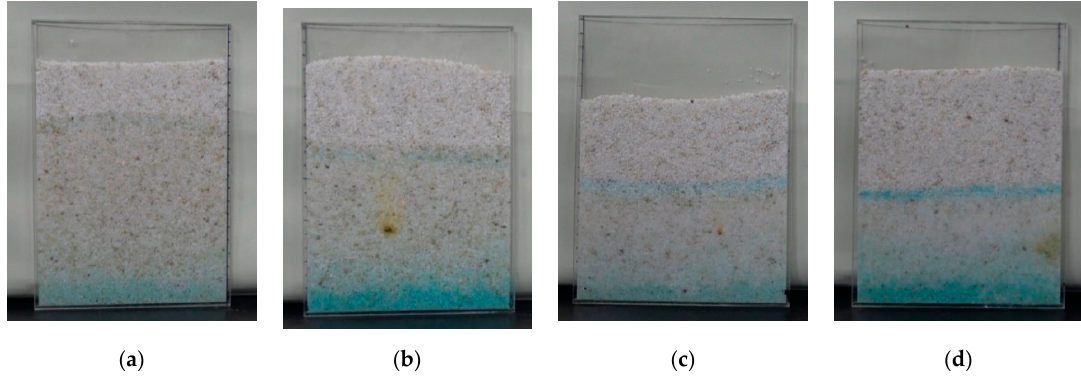
Figure 11. Surface state of the sample after being placed for 67 h. ( a ) i; ( b ) ii; ( c ) iii; ( d ) iv.